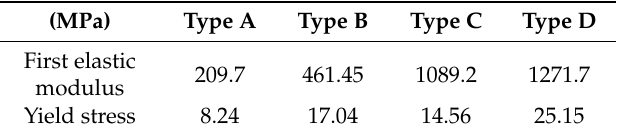
Table 6. The mechanical parameters of four NPR lattice structures.